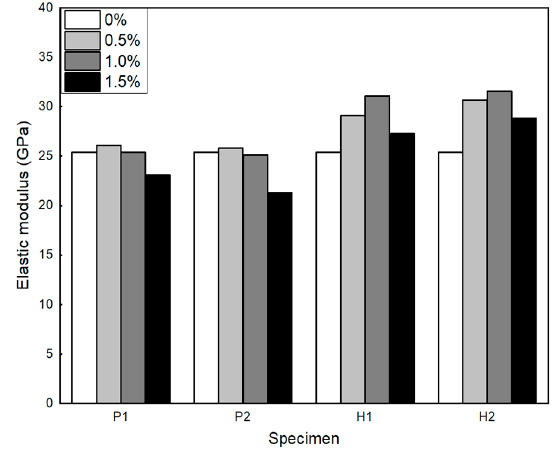
Figure 13. Elastic Figure 13. Elastic modulus. Figure 13. Elastic modulus.